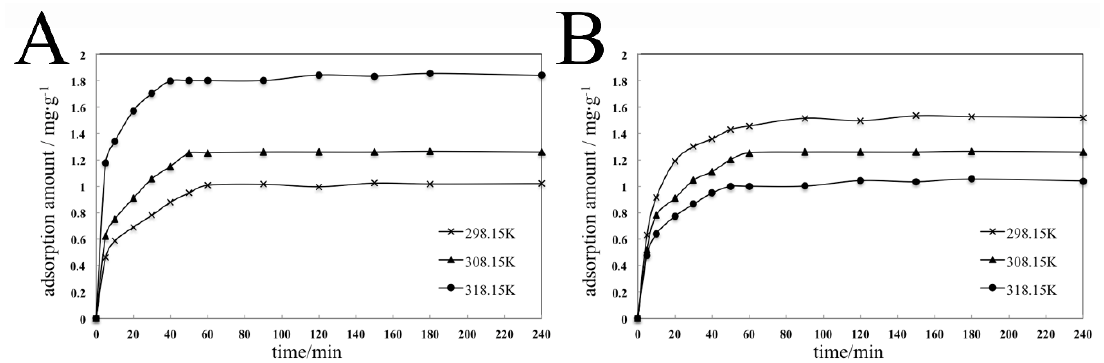
Figure 8. Kinetics adsorption isotherms of the adsorption process of dispersant 2700 on pyraclostrobin crystal II ( A ) and pyraclostrobin crystal IV ( B ) at different temperatures.